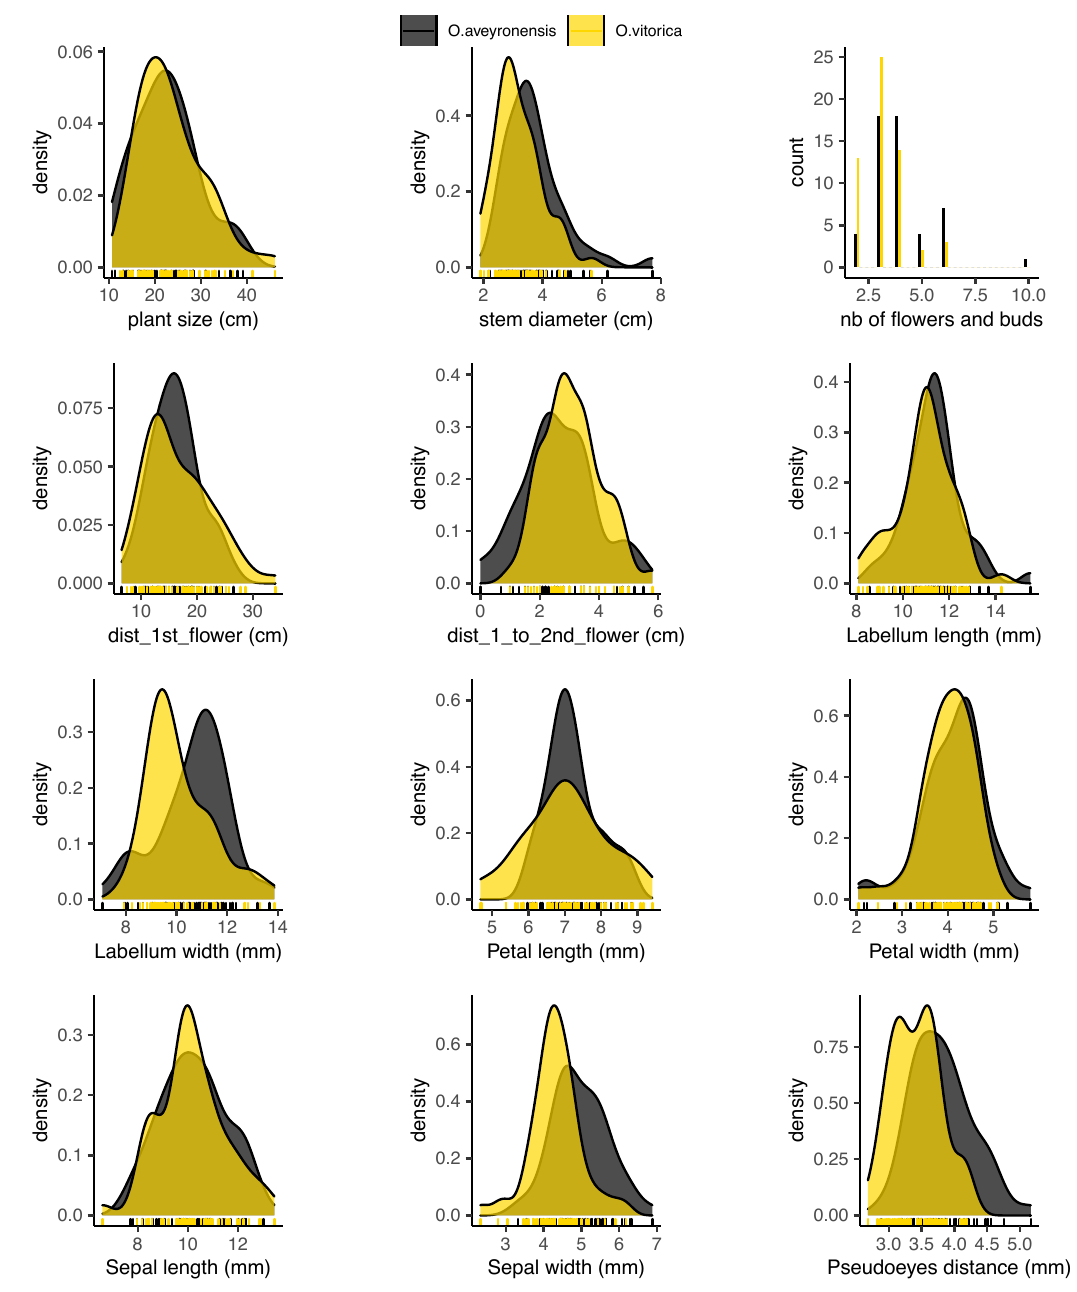
Figure A2. Distribution of morphological traits for O. a. subsp. aveyronensis and O. aveyronensis subsp. vitorica